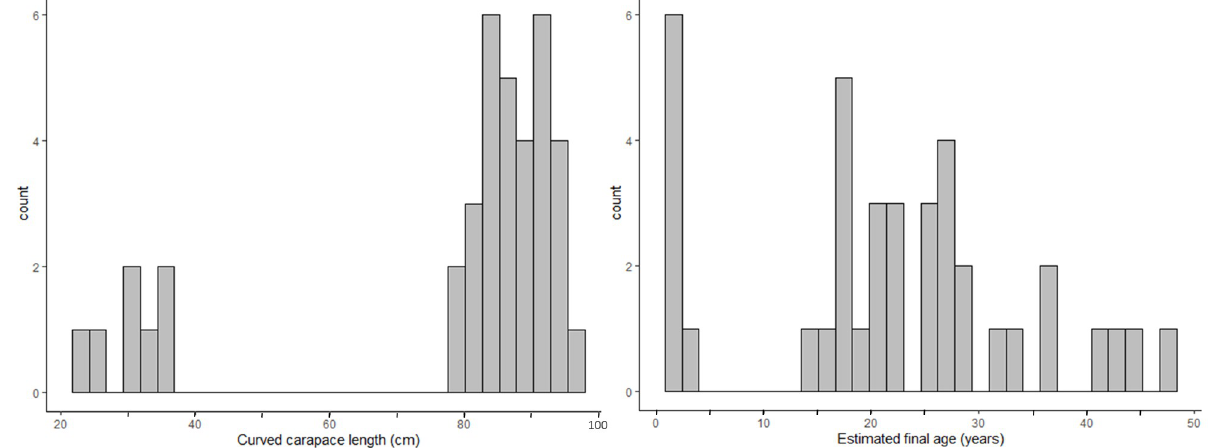
Fig 2. Size and age at stranding. Distribution of non-hatchling flatback sea turtles’ size and estimated age at stranding (n = 38).